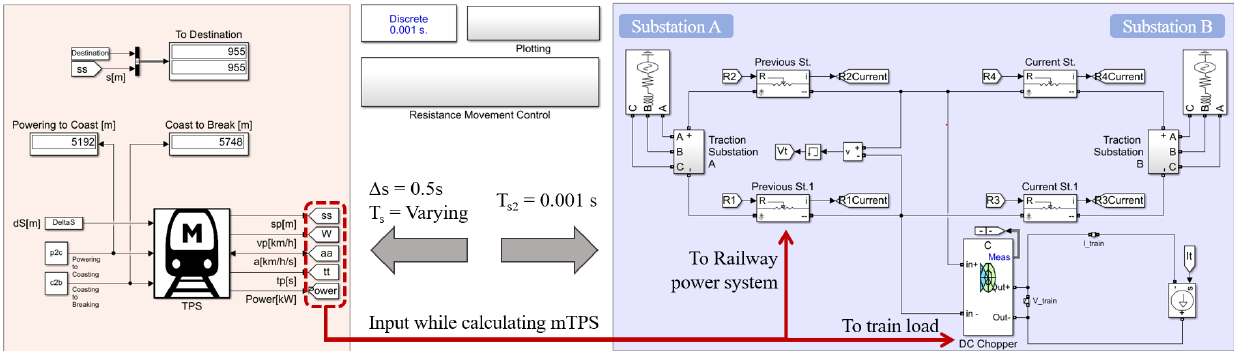
Figure 8. Developed mTPS and TPSS model.